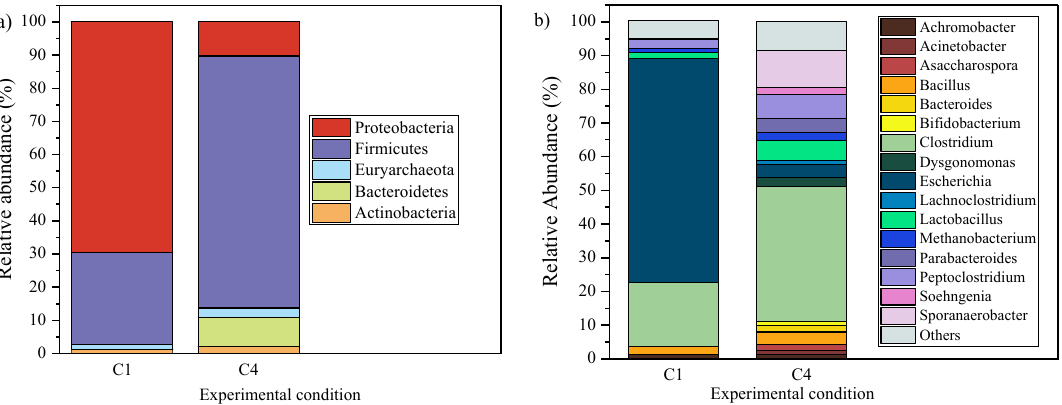
Figure 4. ( a ) Microbial community composition at the phyla level in fermentative systems under conditions 1 (C1) ( S/I = 3 gSV gSV − 1 , pH = 7) and 4 (C4) ( S/I = 1.13 gSV gSV − 1 , pH = 5. ( b ) genera with a relative abundance higher than 1% in the acidogenic fermentation systems (conditions 1 and 4) fed with pretreated OMSW substrate.